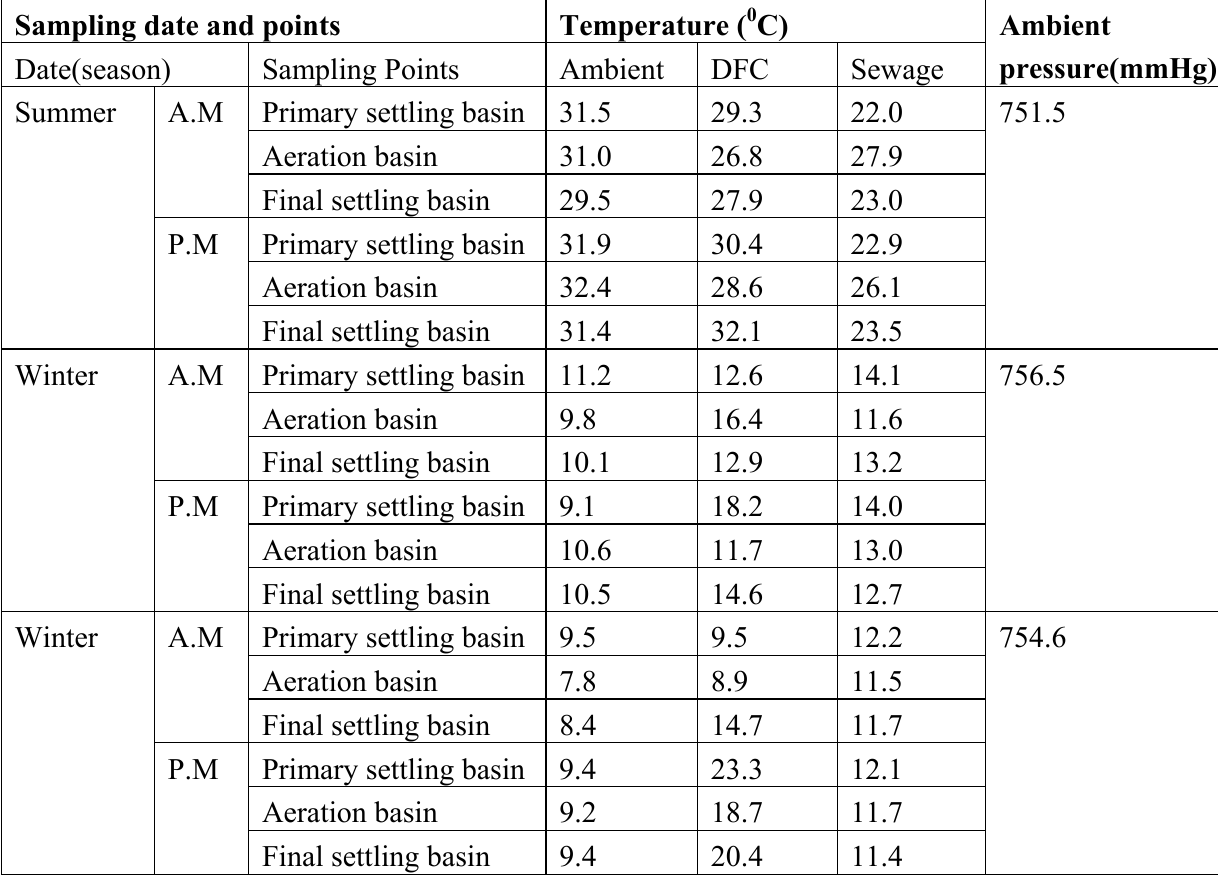
Table 2. Temperature and Pressure of Ambient Air, DFC and Sewage Surface during